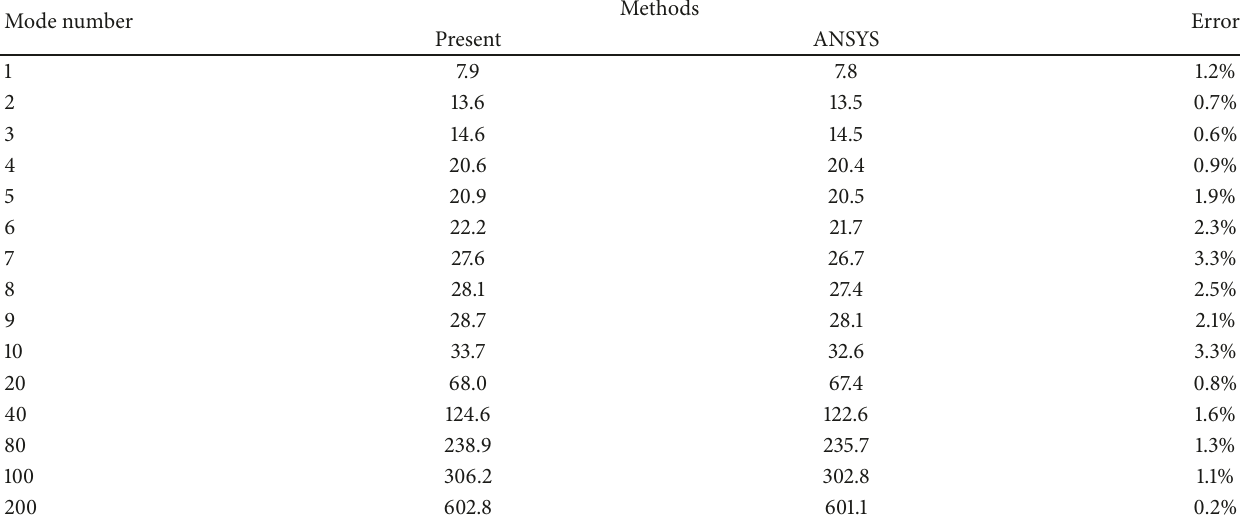
Table 2: Natural frequencies (Hz) for the flexible plate with six